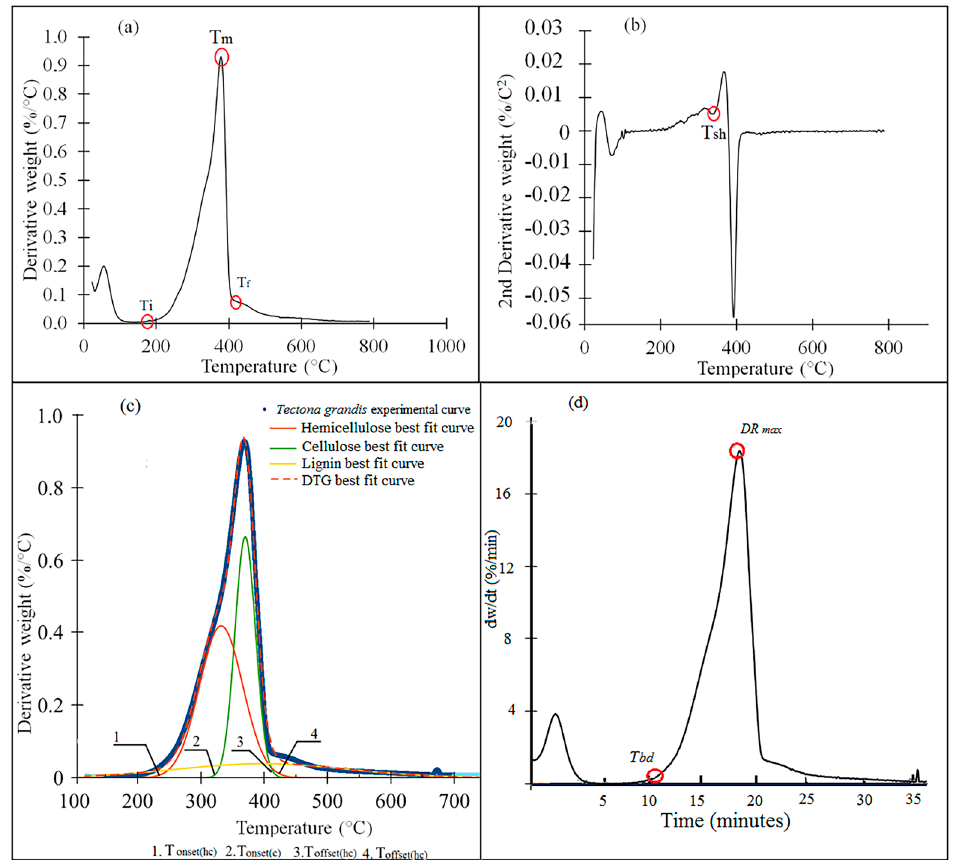
Figure 2. ( a , c ) Derivative thermogravimetry (DTG) and ( b ) second derivative (D 2 TG) parameters for the different woody biomasses analyzed; ( d ) Devolatilization rate measured by first time derivates of the mass frcationas a function of time. Note: t bd is the start time of the maximum devolatilization rate and D max is the maximum devolatilization rate [18].